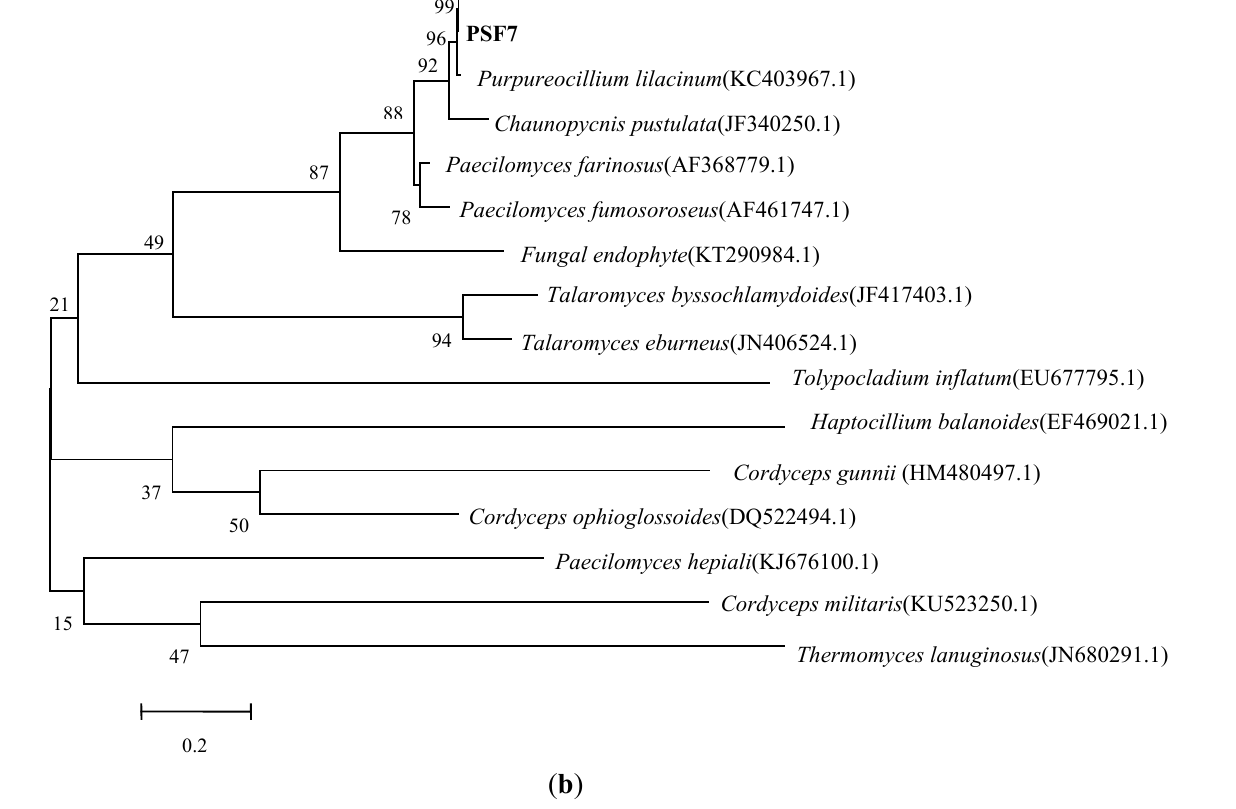
Figure 2. ( a ) Electrophoresis map of ITS sequence PCR amplification of PSF7 and ( b ) phylogenetic tree of PSF7 based on ITS sequences. The sequence numbers in parentheses correspond to the GenBank accession numbers of the reference strains; the numbers at branch points represent confidence level; and Bar, 0.2 substitutions per nucleotide positions.